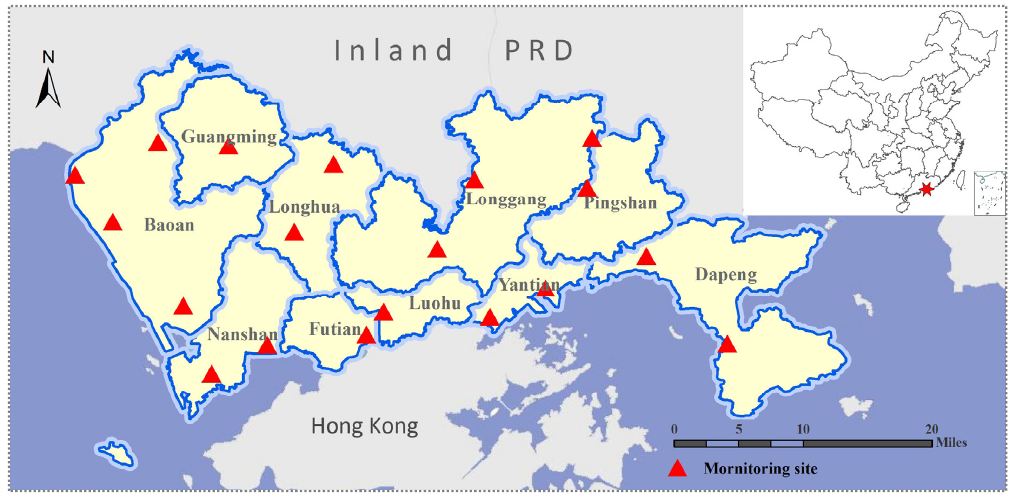
Figure 1. Locations of monitoring sites in Shenzhen.